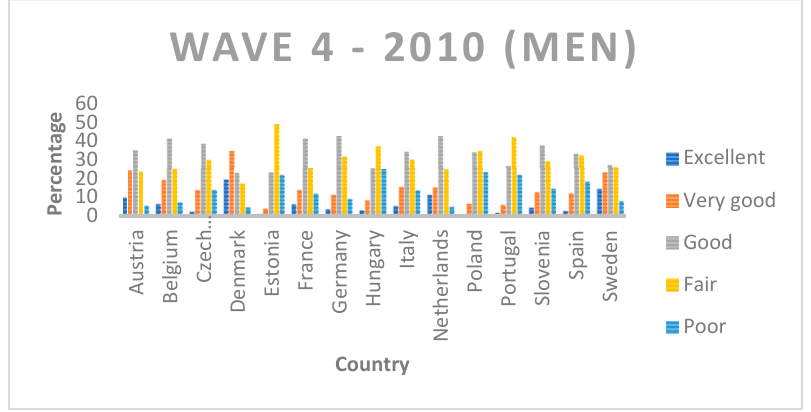
Figure A2. Distribution of women in Wave 2 (2006). Source: Authors’ elaboration based on SHARE (2021).